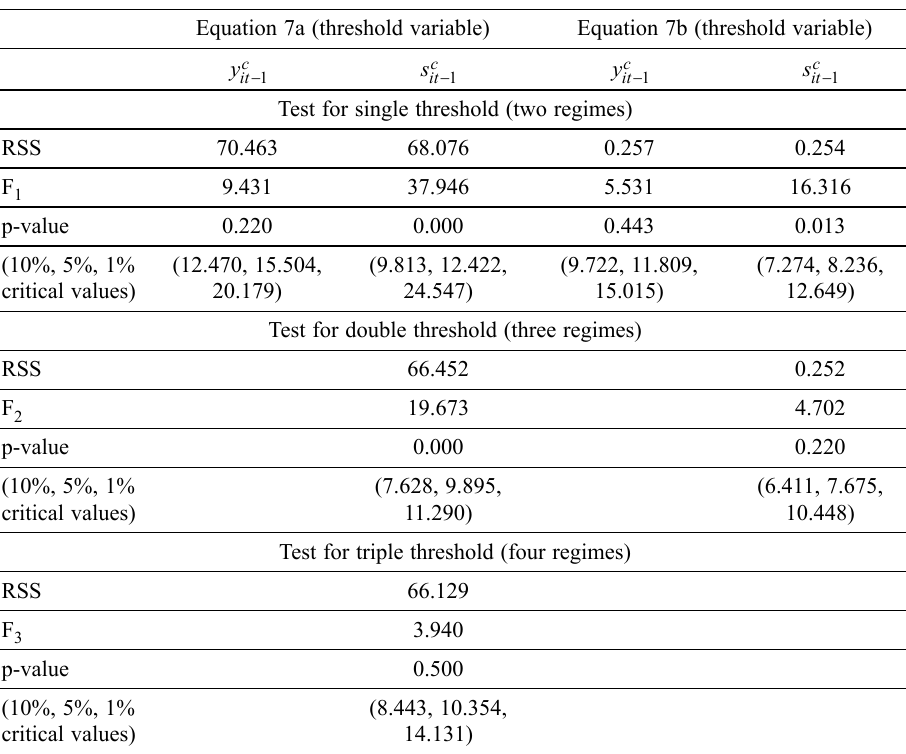
Table 2. Linearity test and tests for threshold